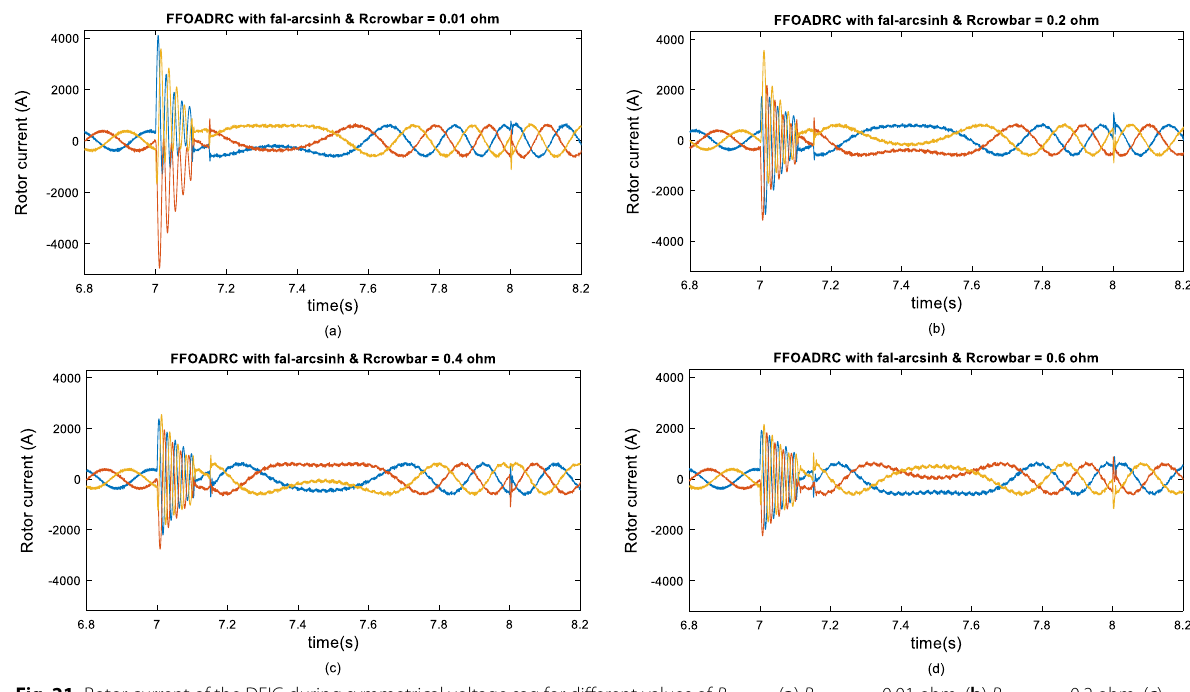
Fig. 21 Rotor current of the DFIG during symmetrical voltage sag for different values of R crowbar . ( a ) R crowbar R crowbar 0.4 ohm, and ( d ) R crowbar =